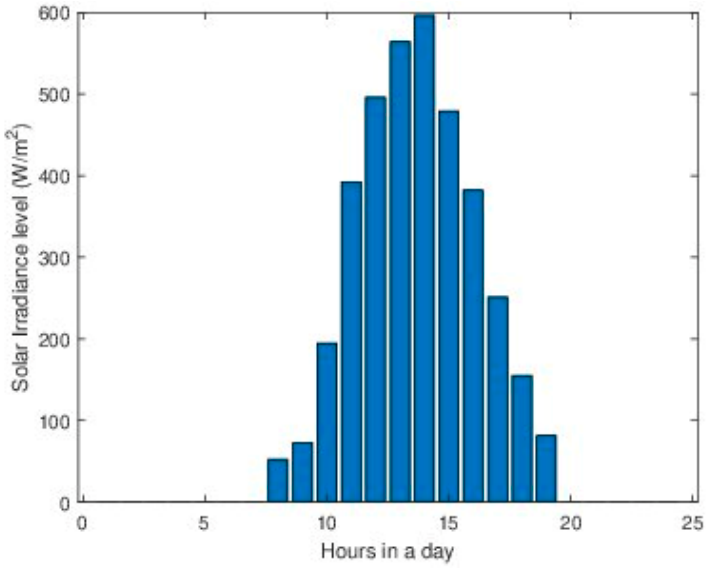
Figure 17. Predicted solar irradiance profile.